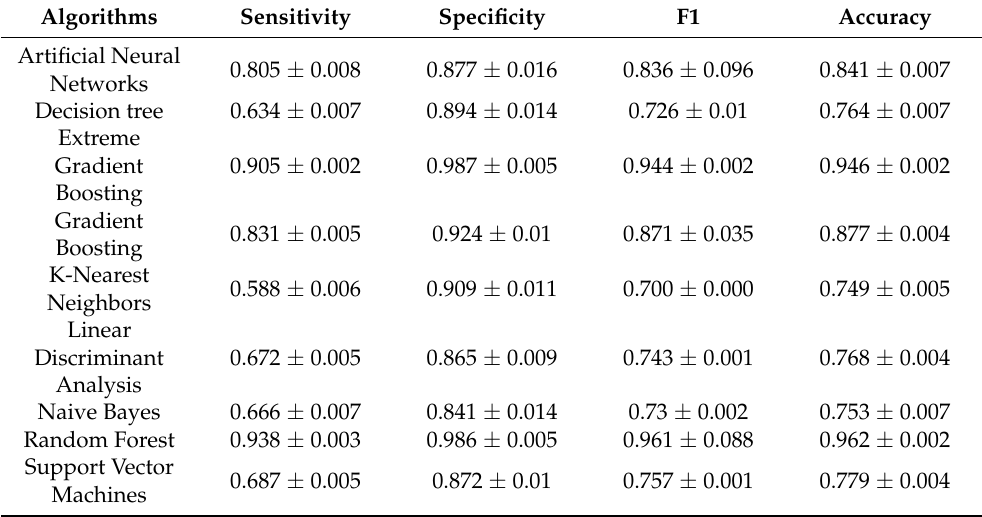
Table 2. The mean (SE *) of the sensitivity, specificity, F1, and accuracy of the classification of Aleutian disease using nine machine learning